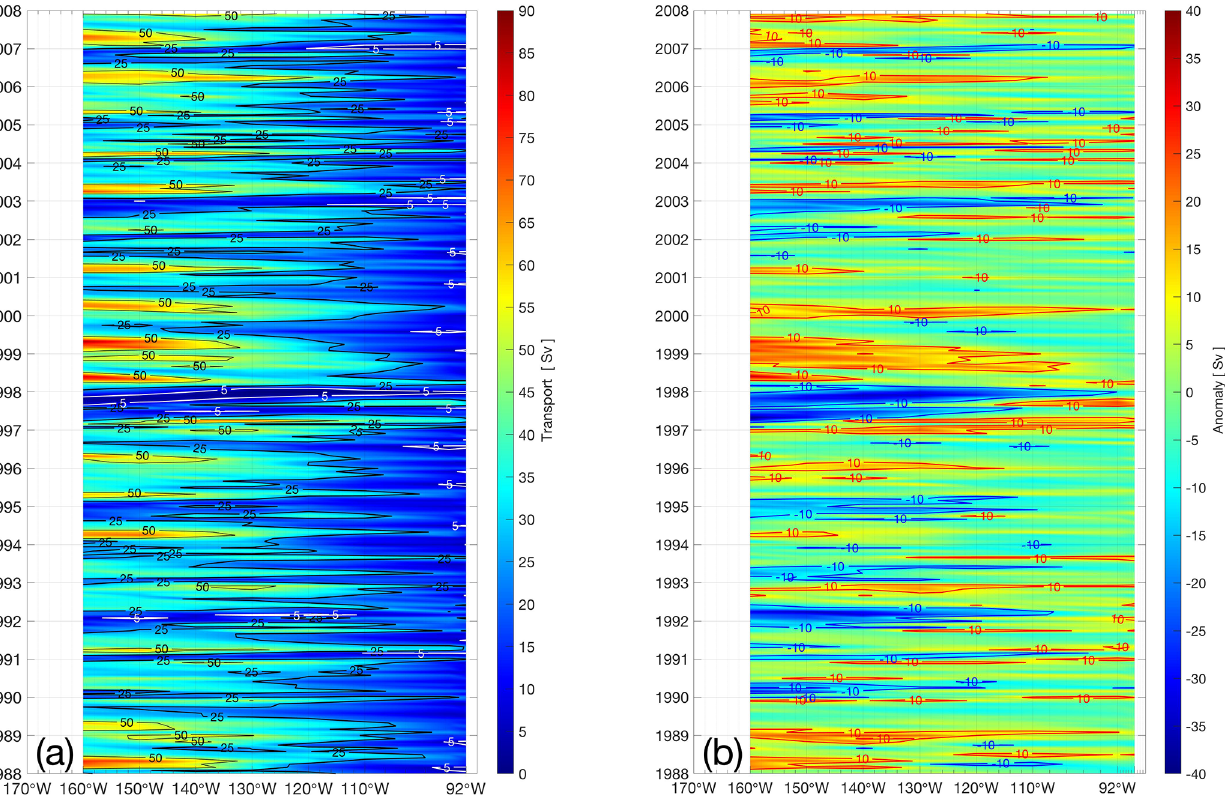
Figure 6. Integrated EUC transport based on calculations at 160, 150, 140, 130, 120, 110, 95 and 92 ◦ W (Galápagos Islands), in the latitude range 3 ◦ N–3 ◦ S where the concentration of particles backtracked is the highest: (a) monthly averages; (b) monthly